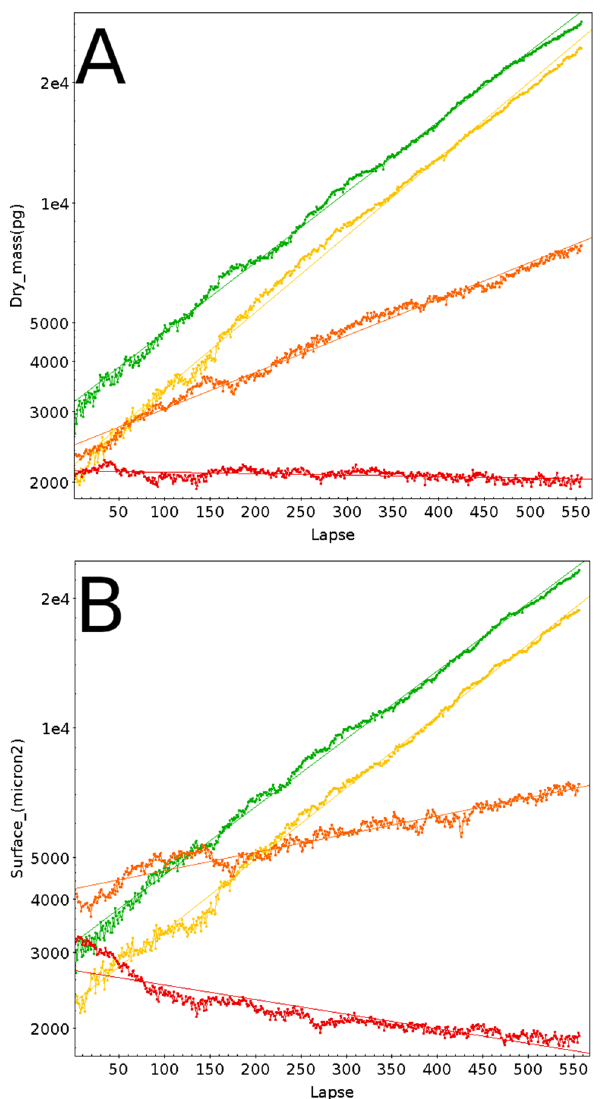
Figure 4. ( A ) Average of the 9 fields monitored for the 4 STS concentrations depicted in Fig. 3, with the same color code. Green: 4 nM STS, yellow: 20 nM STS, orange: 100 nM STS, red: 500 nM STS. ( B )Same as ( A ), but using Surface features instead of Dry